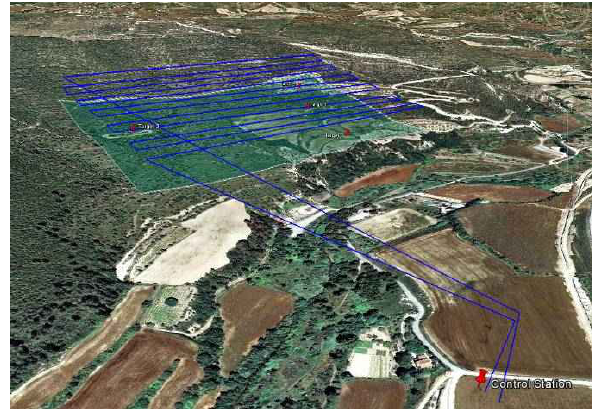
Figure 3: Route executed for a search mission in CLOSE-